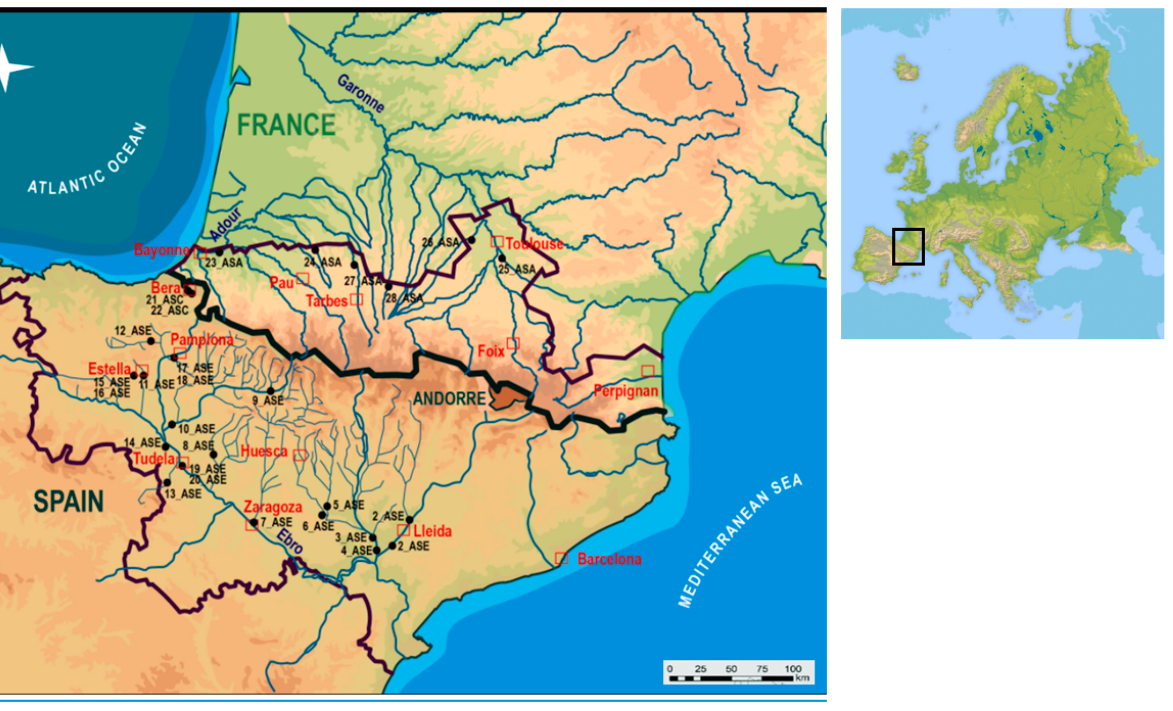
Figure 1. POCTEFA territory and surface sampling points.